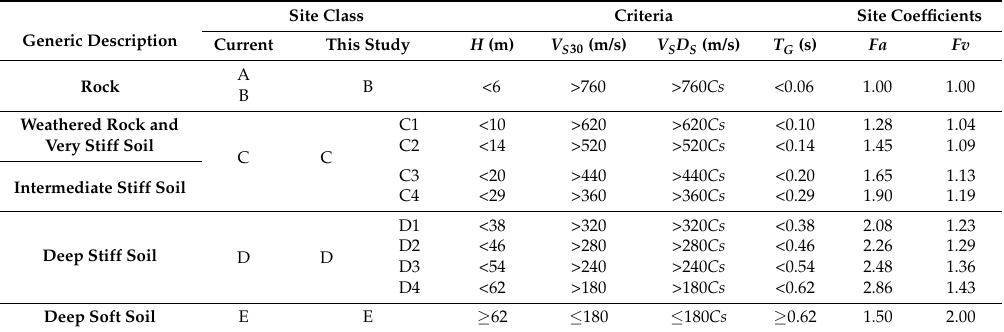
Table 1. Domestic site classification system applying criteria including the site period (modified after Sun